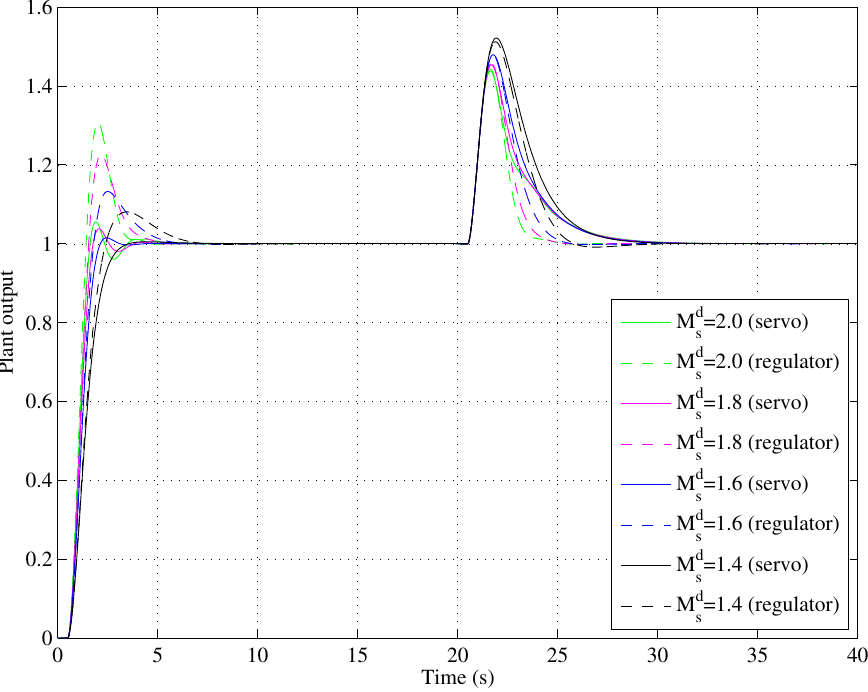
Figure 10. Servo and regulation performances for a = 0.3.